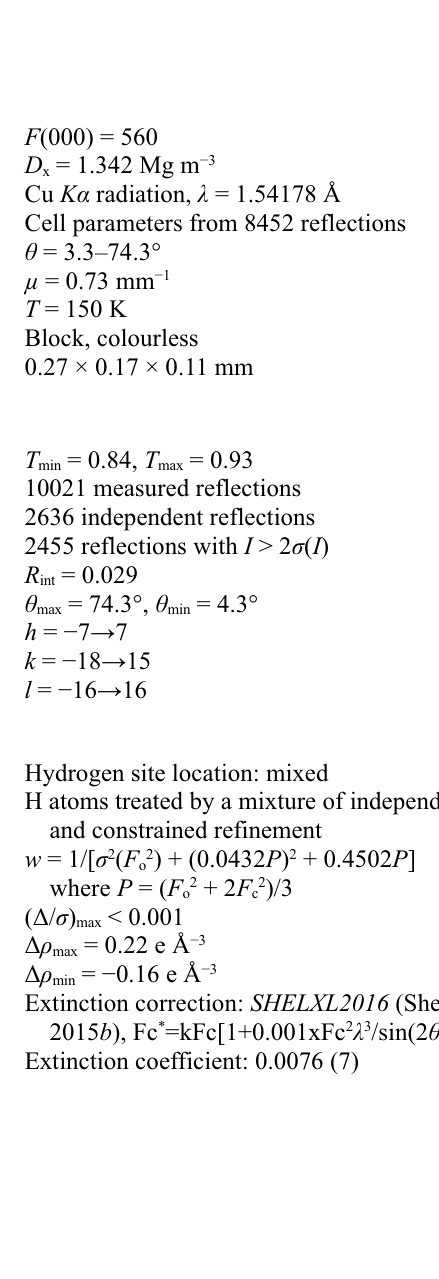
data-1 IUCrData (2017). 2 ,